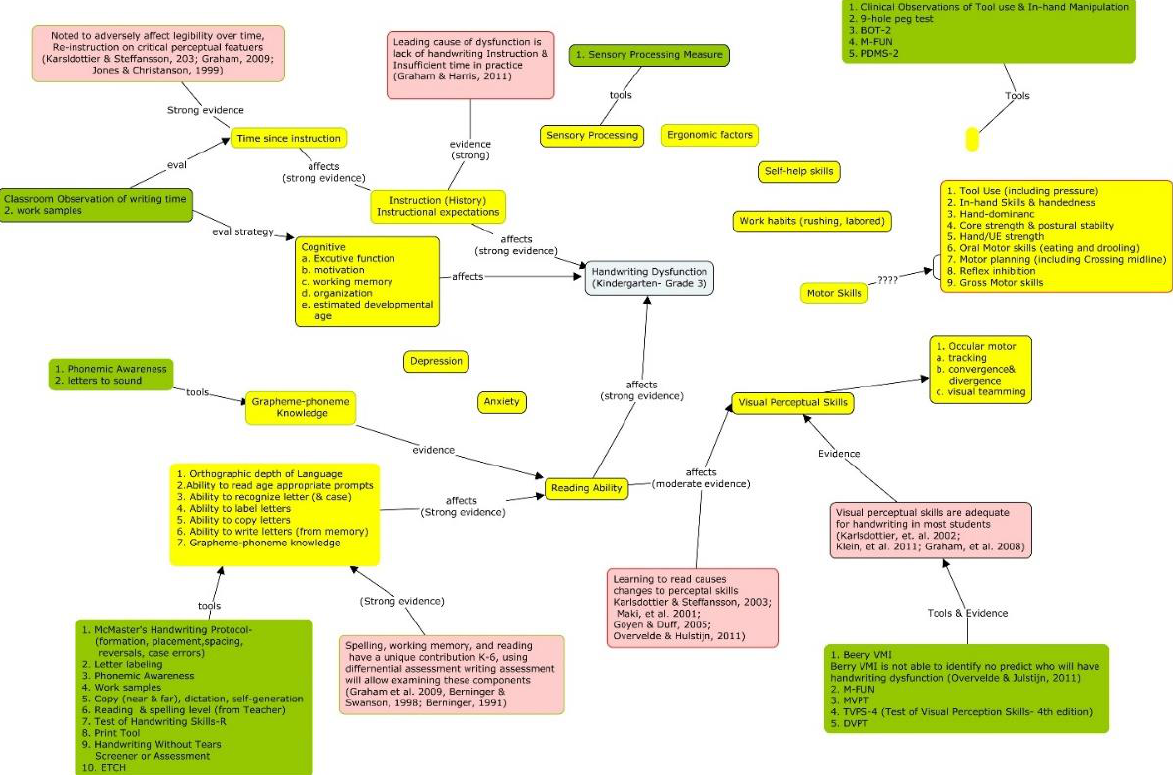
Figure 4. Evidence-informed causal model with interventions and assessment tools suggested in the literature. Blue indicates the target problem. Yellow indicates factors which are believed, theoretically and/or empirically to have a relationship to the target outcome. Pink indicates evidence on the factor’s relationship to other factors or target problem. Green indicates assessment tools.